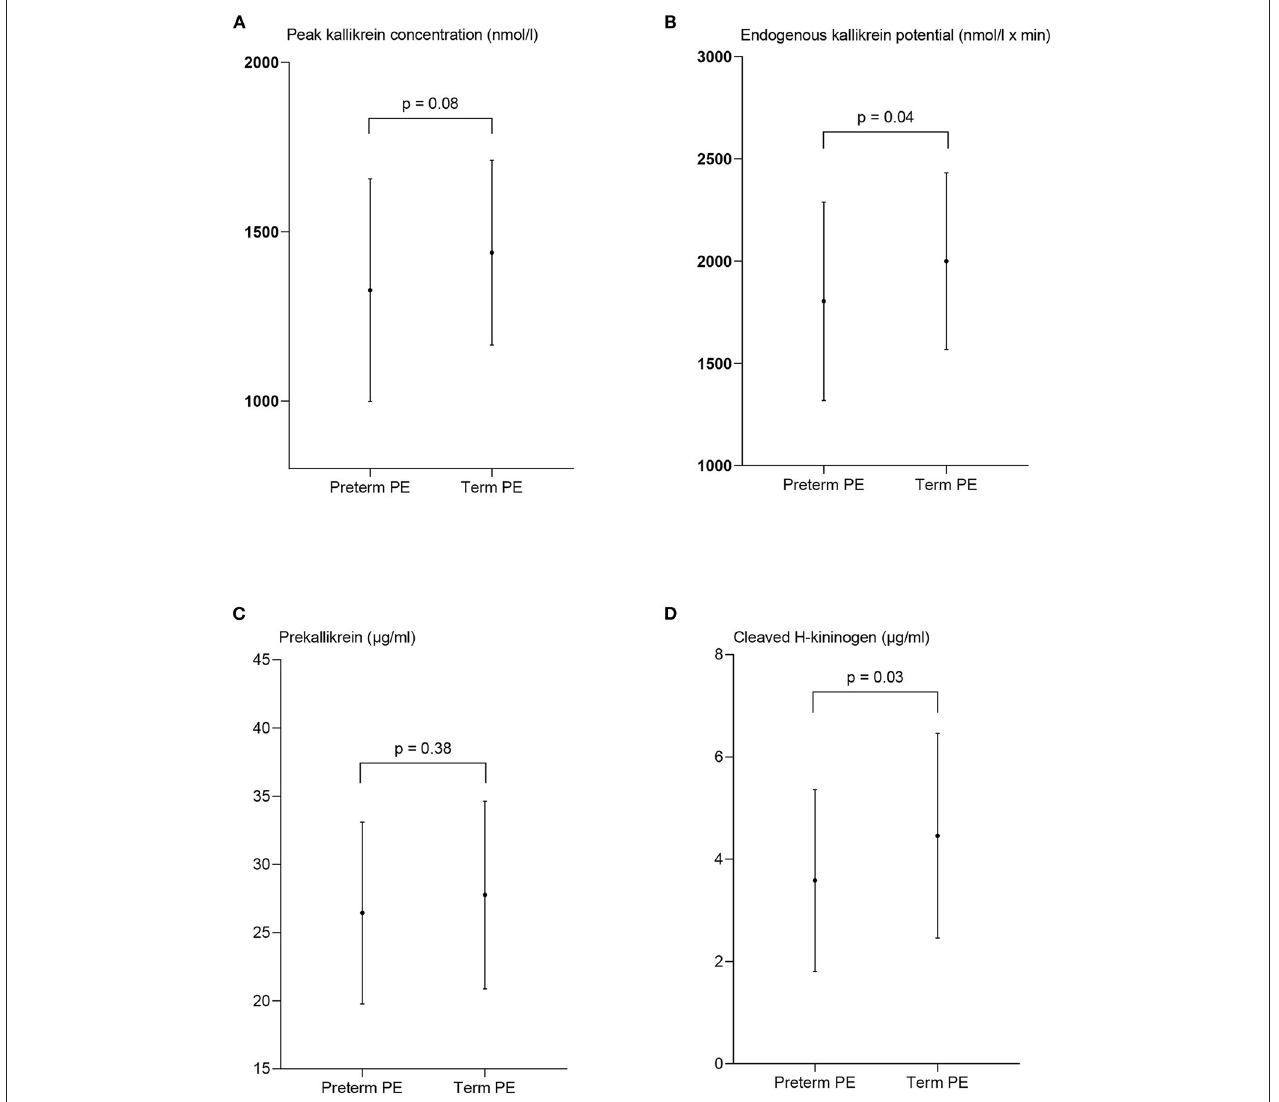
FIGURE 5 | Measures of contact activation in women with preterm preeclampsia and term preeclampsia (PE). The peak kallikrein concentration (A) , endogenous kallikrein potential (B) , prekallikrein concentration (C) , and the concentration of cleaved H-kininogen (D) are presented as mean ± standard deviation. p -values from the paired t -test between the two patient